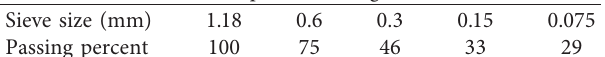
Table 1: Asphalt mastic